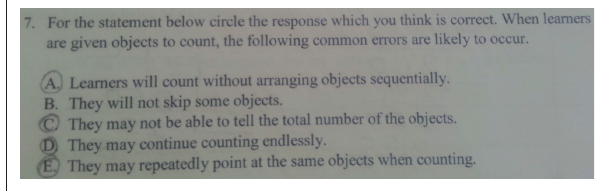
FIGURE 12: Response of Teacher 12.